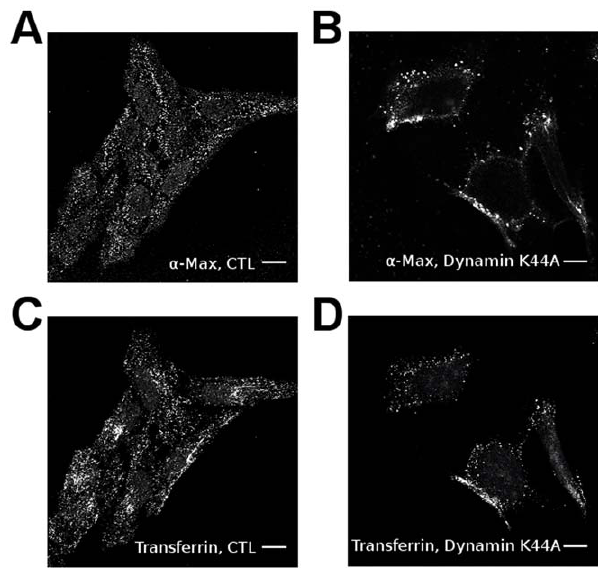
Figure 4. The transfection of the defective Dynamin1 K44A mutant blocks the endocytosis of Max* into HeLa cells. Confocal photomicrographs of HeLa cells transfected or not with a vector encoding for the dominant-negative mutant of dynamin1 (K44A) and incubated with Max* and AlexaFluor-488 transferrin for 20 minutes at 37 u C (subsequent to a 30 minutes pre-incubation period at 4 u C). Immunofluorescence staining of Max* without A) and with B) the transfection of the Dynamin1 (K44A) mutant. Fluorescence of Transfer- rin- AF488 without C) and with D) the transfection of the Dynamin1 (K44A) mutant. Scale bar=10 m m.